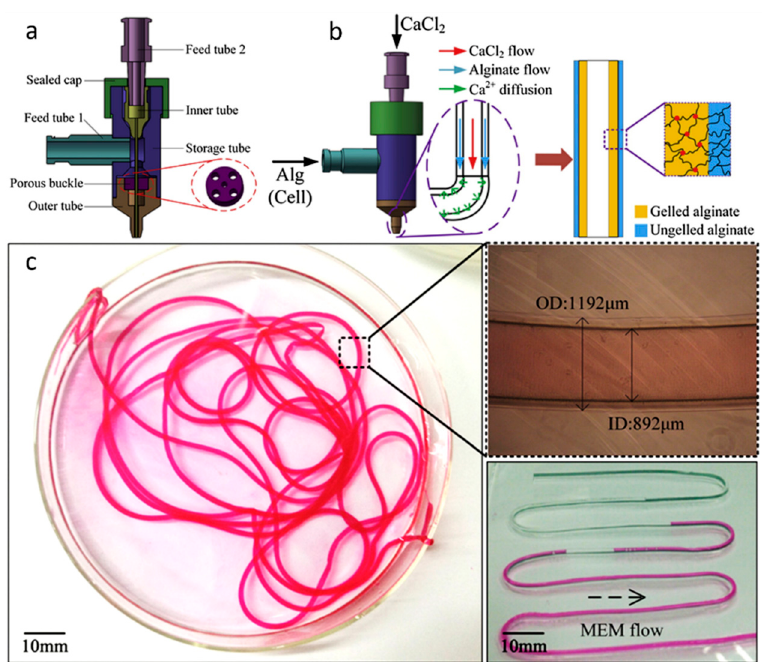
Figure 15. Example of SNMJ. Fabrication of the heterogeneous GelMA microfibers and 3D constructs. ( A ) Schematic illustration of the generation of GelMA microfibers with Janus structure. ( B ) Fluorescence microscopy images with two compositions GelMA microfibers. ( C ) Fluorescence microscopy images with different composition ratios (1:1, 2:1, and 3:1) of GelMA microfibers. ( D ) Schematic of the programmable bioprinting for the generation of programmed GelMA microfibers (R, red; G, green). ( E ) Programmed GelMA microfibers with controllable compositions. Panels ( A – C ) refer to a side-by-side SNMJ. Panels ( D , E ) refer to gradient formation. Reprinted from Bioprinting of Cell-Laden Microfiber: Can It Become a Standard Product?, Shao et al. Copyright (2019), with permissions from Wiley [172].